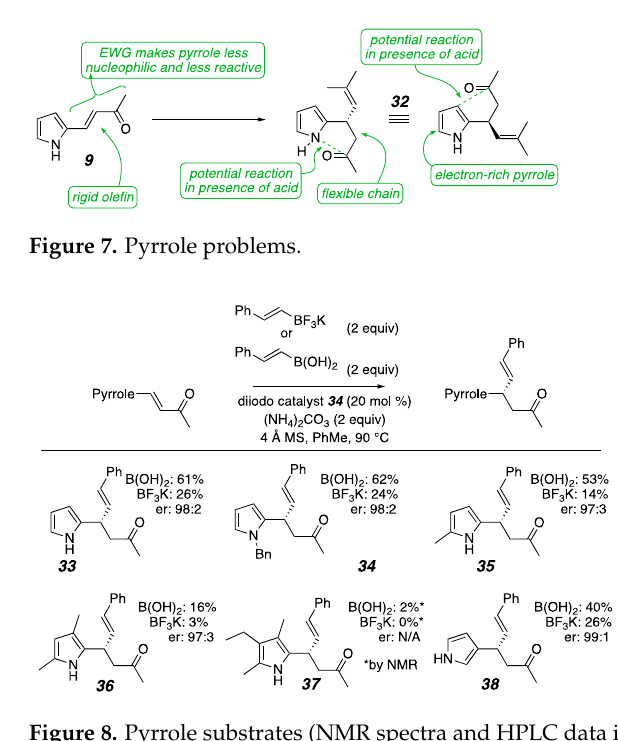
Figure 8. Pyrrole substrates (NMR spectra and HPLC data in Supplementary Materials). Table 1. Optimizations of additives with 2-pyrrolyl enone. 0.20 mmol 27 with 0.02 mmol catalyst